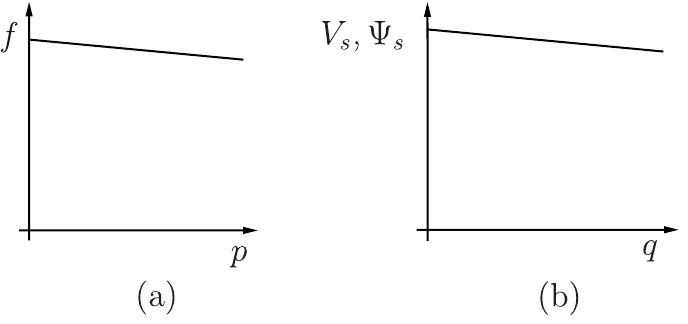
Figure 5. ( a ) Droop control of frequency. ( b ) Droop control of voltage or stator flux